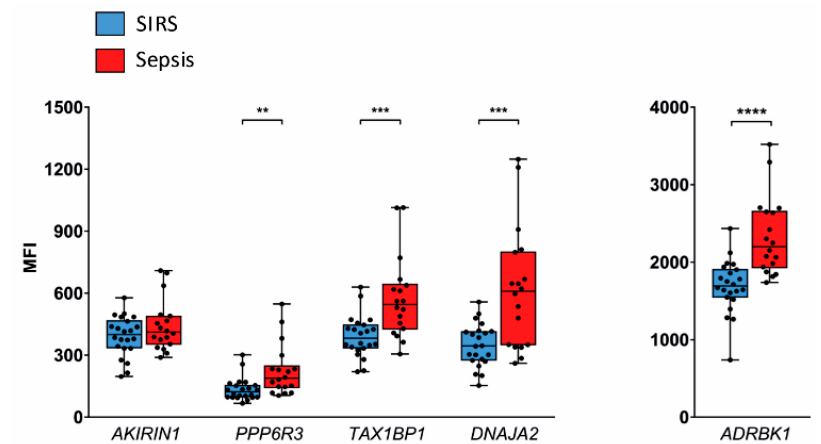
Figure 6. Assessment of candidate reference genes validated for NK cells in granulocytes from the validation set by QGP. Results are grouped by similar signal intensity (MFI) ranges. Data are represented as blue (SIRS, n = 22) and red (sepsis, n = 18) box plots with whiskers from minimum to maximum, median, and dispersion plots. ** p < 0.01, *** p < 0,001, **** p < 0.0001 from the Wilcoxon rank-sum